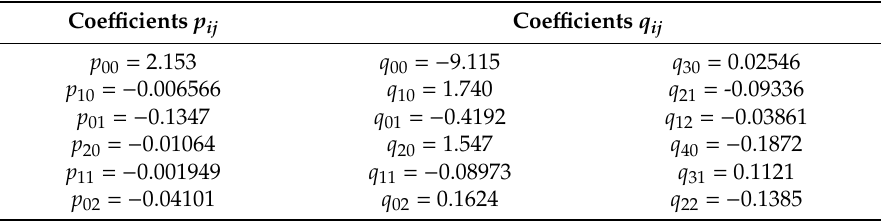
Table A1. Fit coe ffi cients for (A1).